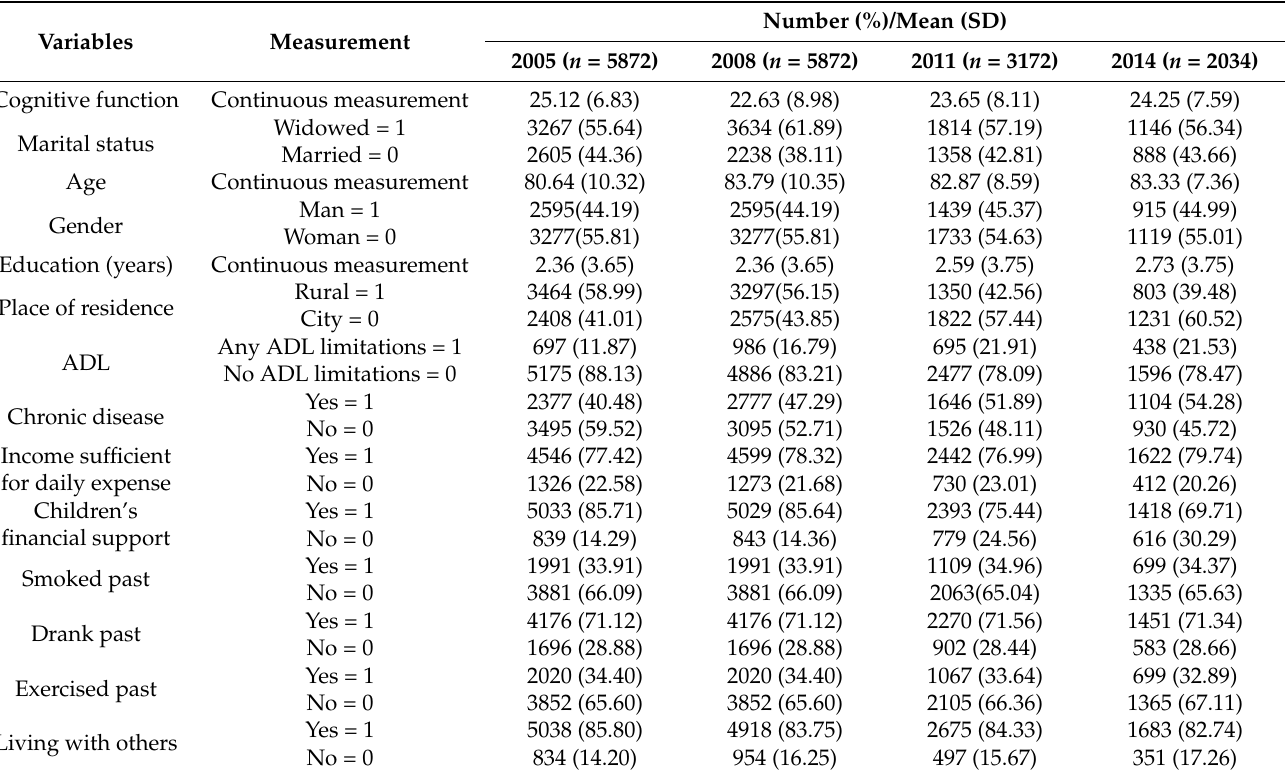
Table 1. Descriptive statistics of the study sample (2005–2014).